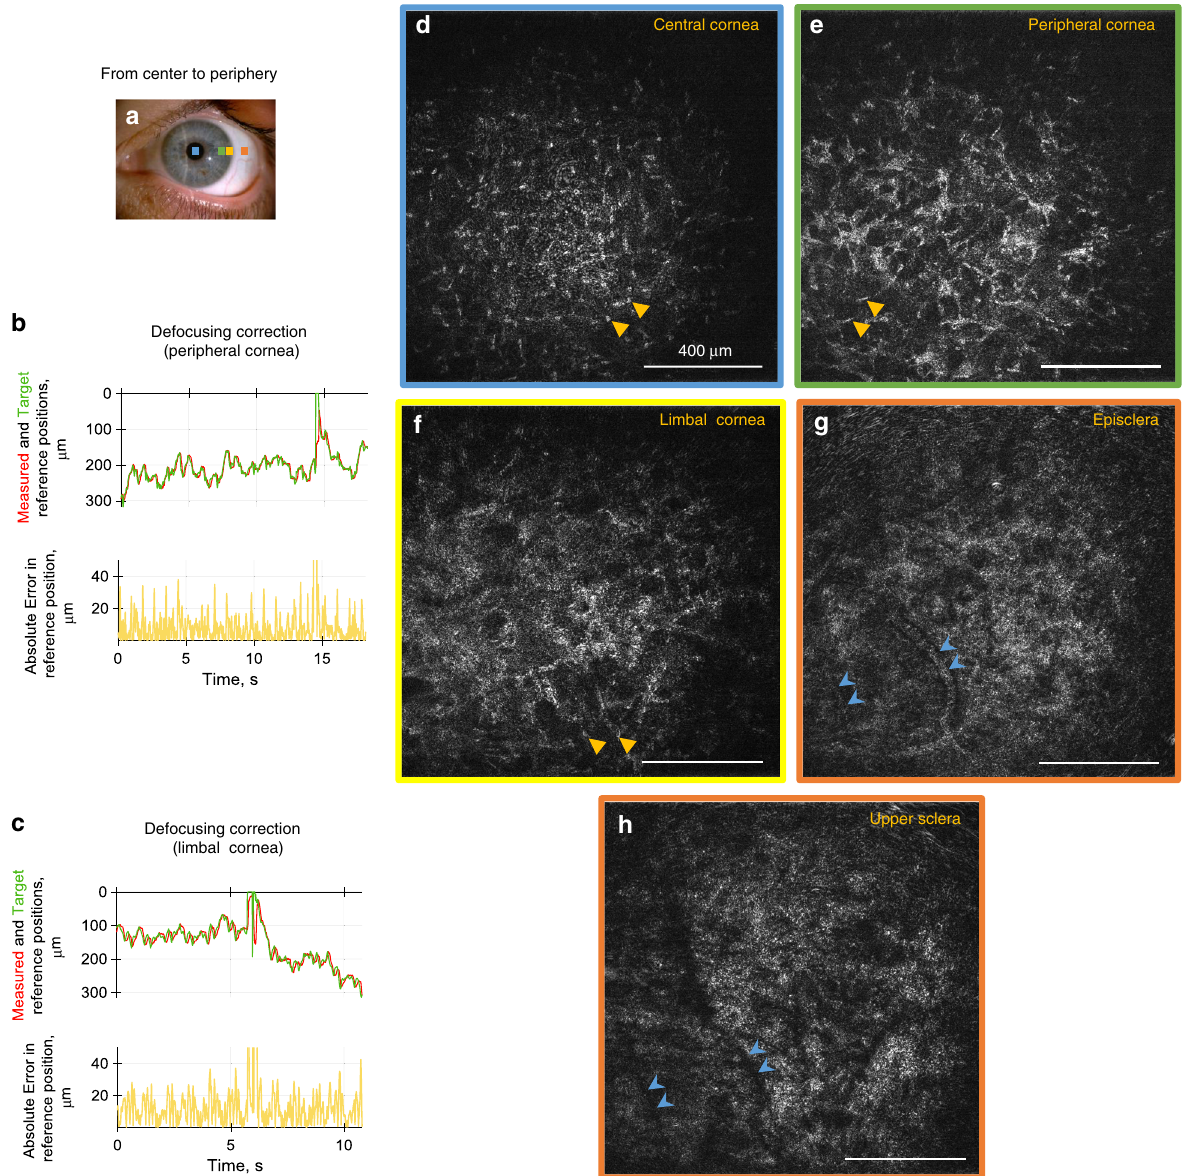
Fig. 6 Common-path FF/SD OCT imaging of peripheral human cornea, episclera and upper sclera in vivo. a Slit-lamp macro photo obtained from one of the subjects. Squares depict the peripheral locations, where FFOCT images were acquired. b , c Performance of real-time defocus correction, when imaging the corneal periphery. Measured reference mirror position (red), required reference location for ideal defocus correction (green) and error between the two (yellow). Peaks at 6 and 14 s correspond to blinks. Positioning errors were 11.3 ± 7.2 µ m and 7.2 ± 6.6 µ m (mean ± s.d.) estimated from 1022 and 1222 positions acquired over 18.2 and 10.8 s, respectively. d – h Single frame FFOCT images from central cornea to periphery, extracted from real-time movies (Supplementary Movies 8, 9). Resolving individual keratocyte nuclei (yellow arrows) was increasingly more dif fi cult, when imaging further from the center, due to stronger light scattering from the stromal fi brils and consequent glare over the entire image. Blue arrows show vessels of episclera, which produced shadows in the upper sclera. The source data underlying plots in b and c are provided as a Source Data fi le. All unlabeled scale bars 400 µ m. Experiments were reproduced several times in each of the three healthy